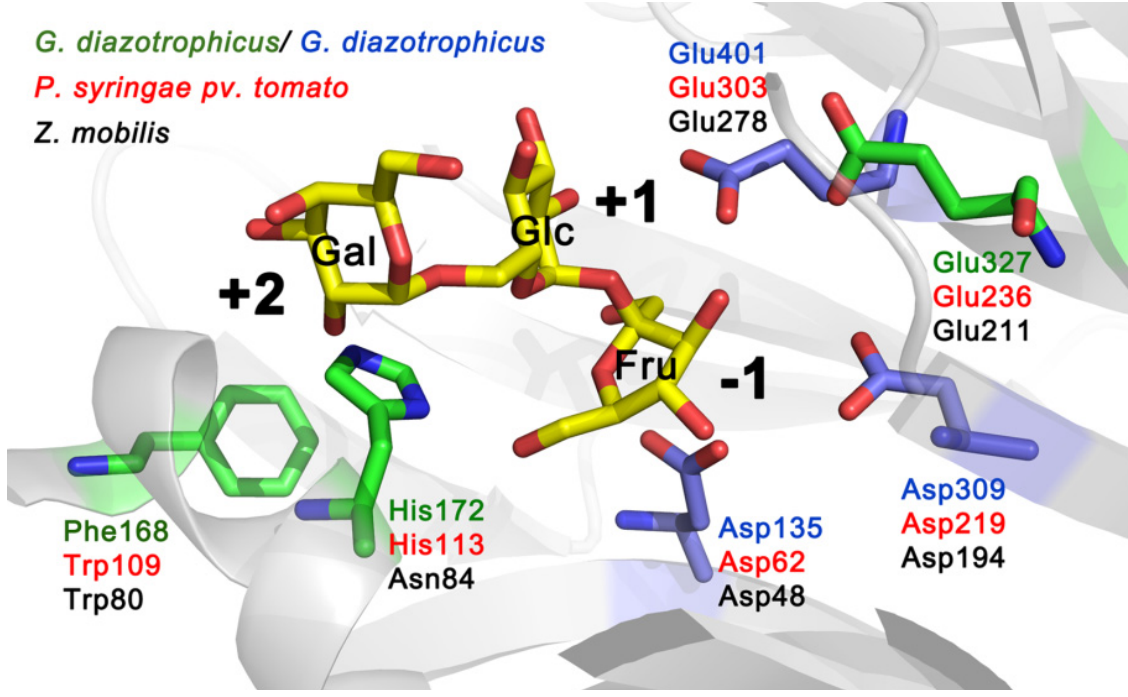
Figure 2. Catalytic centre of G. diazotrophicus levansucrase LsdA (PDB ID: 1W18; [5]) with side chains of catalytic triad residues (Asp135, Asp309 and Glu401) indicated in blue. The structure of the protein was visualized using PyMol [27]. Raffinose (consisting of galactose, glucose and fructose residues) shown in substrate-binding pocket originates from the structure of the B. subtilis levansucrase SacB in complex with raffinose (PDB ID: 3BYN) that was superimposed with the LsdA structure. Positions of LsdA equivalent to Trp109, His113 and Glu236 of Lsc3 of P. syringae pv. tomato are shown on the model. Respective amino acids of levansucrases of different bacteria are shown in different colour: LevU of Z. mobilis ( black ), Lsc3 of P. syringae pv. tomato ( red ) and LsdA of G. diazotrophicus ( green and blue